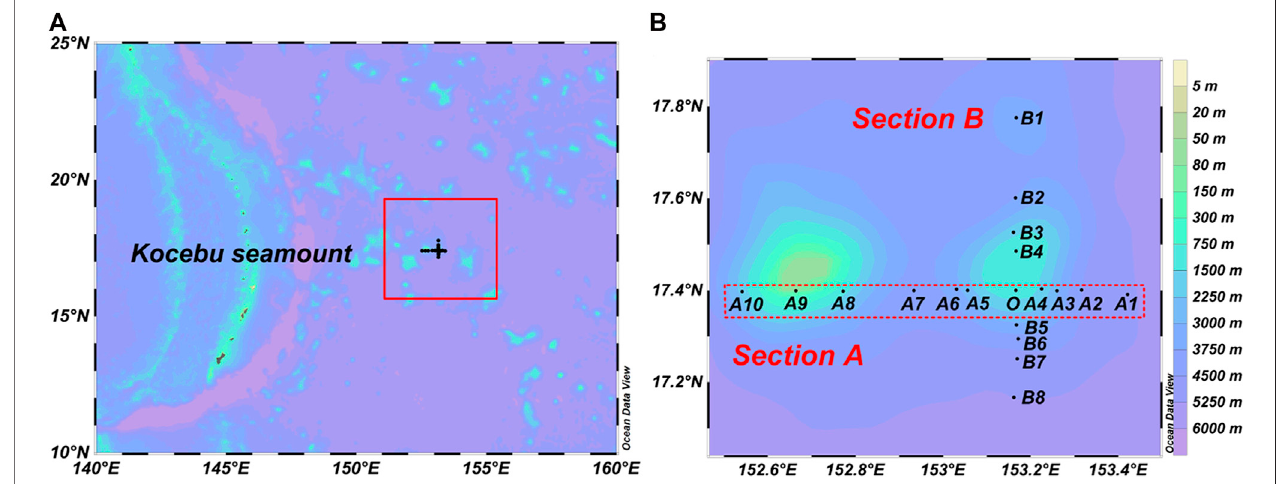
FIGURE1| SamplingstationsintheKocebuseamountareaoftheTropicalWesternPaci fi cOcean. (A) TheKocebuseamountareawasmarkedbytheredsquare, whichwaslocated onthe rightside oftheMariana Trench. (B) There weretwosections, and thered rectangle representedSection A. 19stations were set upabove the Kocebuseamount. Thetwosections intersect StationOat awaterdepth of1,195 mabove theeast summit ofthe seamount. This fi gure wascreated using Ocean Data View.